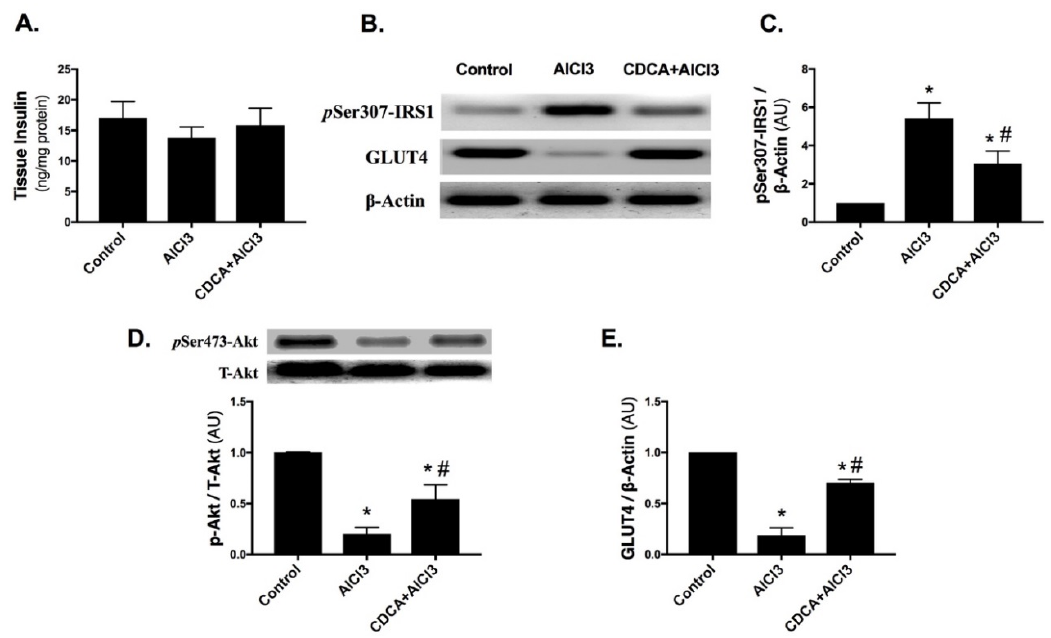
Figure 3. CDCA enhances ( A – E ) insulin signaling in AD rat model. Data are presented as mean ± SD ( n = 6 for tissue insulin and n = 4 for western blot). Statistical analysis was carried out using one-way ANOVA followed by Tukey’s post-hoc test . P < 0.05; as compared to (*) control and (#) AlCl 3 group.